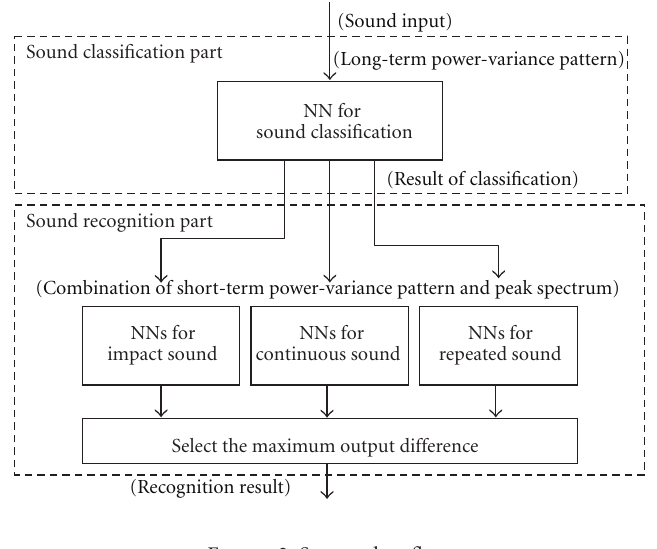
Figure 2: System data flow.